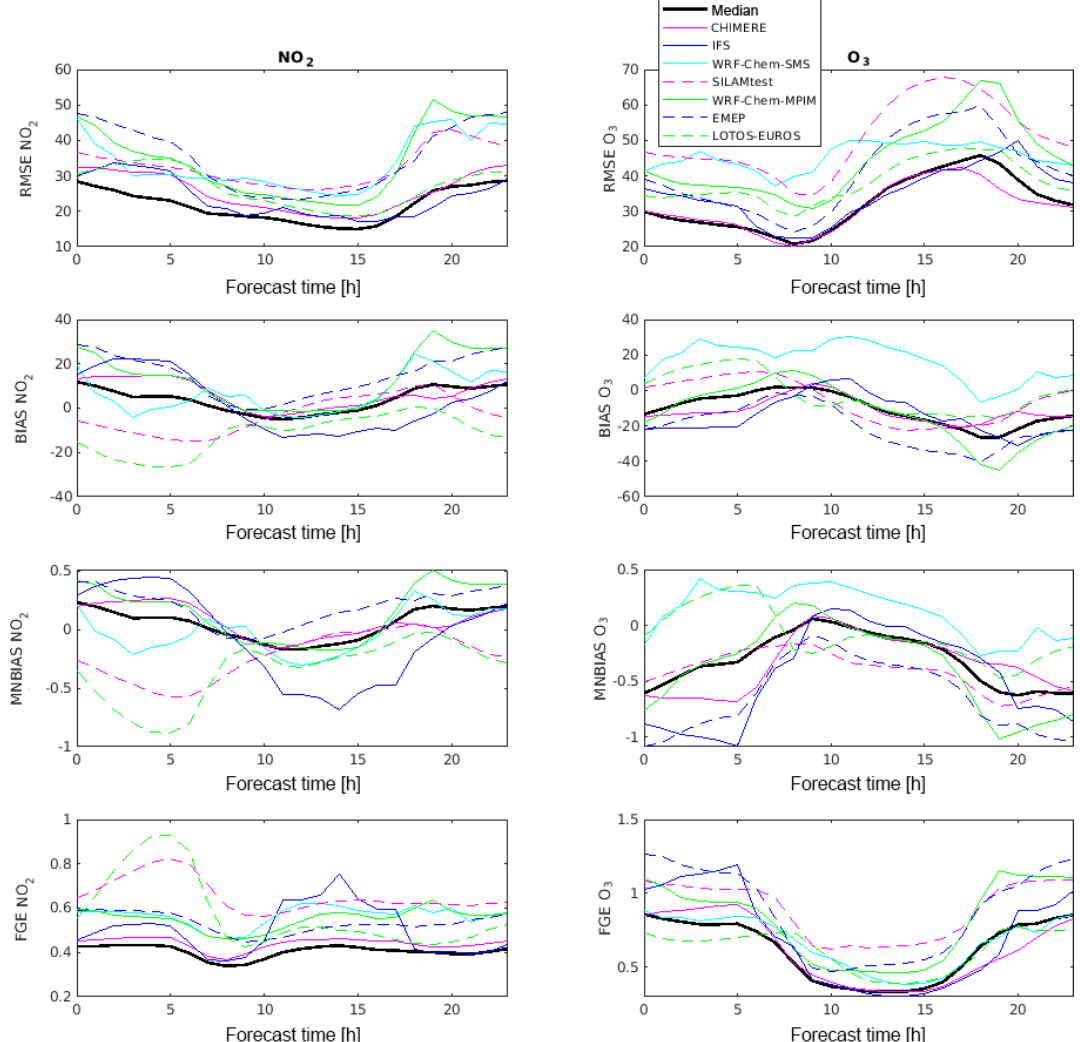
Figure 6. RMSE, BIAS, MNBIAS, and FGE of NO 2 and O 3 over the forecasting time (time of the